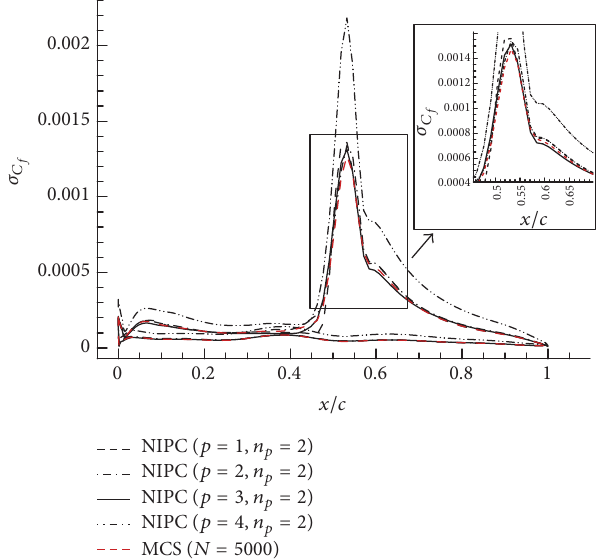
Figure 6: Standard deviation distribution of 𝐶 𝑓 with the order of